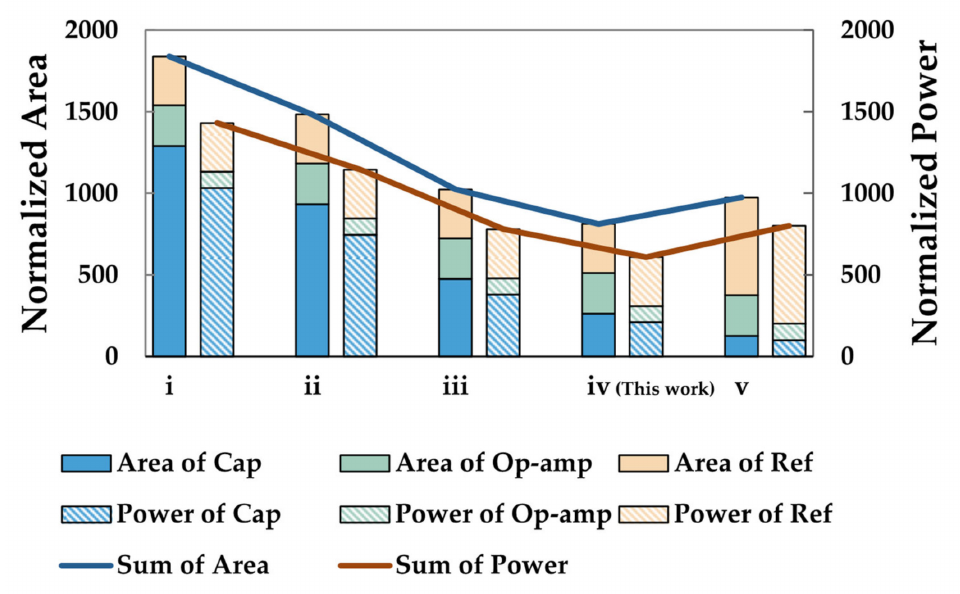
Figure 7. Comparison of area and power between different architectures. Each component in the stacked bar is marked with different colors and grains, as illustrated below. The normalized area and power are compared in left and right, respectively. The trend lines of the sum area (blue) and power (brown) indicate that the architecture in this work achieves the best